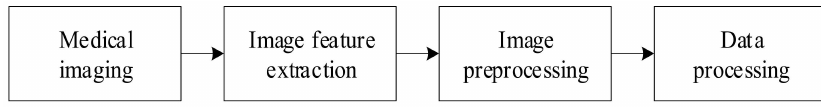
Figure 2. The process of image